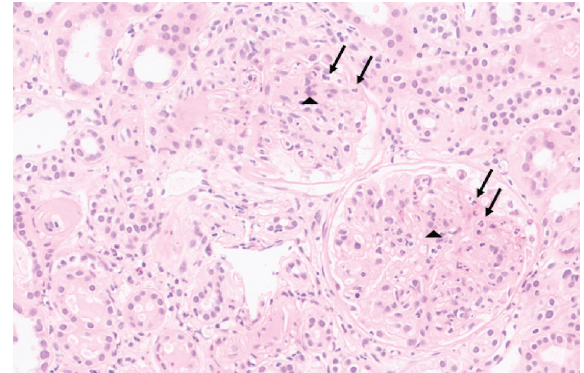
Figure 1: Renal biopsy with glomerular mesangial expansion and mesangial hypercellularity, including segmental neutrophil influx (arrows and arrowheads) (H&E, original magnification, × 200). H&E: hematoxylin and eosin.